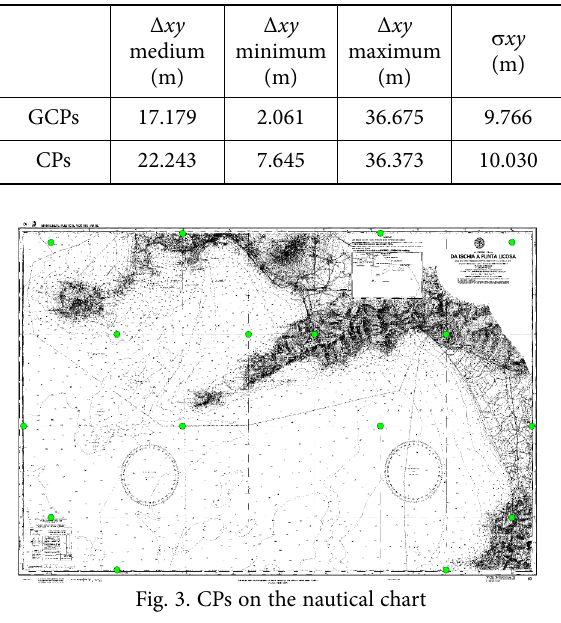
Table 2. Residuals (in meters) obtained for GCPs and CPs for nautical chart georeferencing using Polynomial Functions 1st order